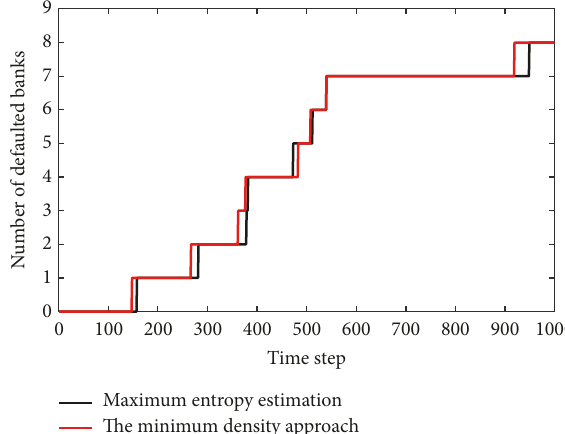
Figure 4: Time variations in number of defaulting banks in Kenyan banking system with the network estimated by maximum entropy estimation method and the minimum density approach in the year 2015 with parameter 𝑐 = 10